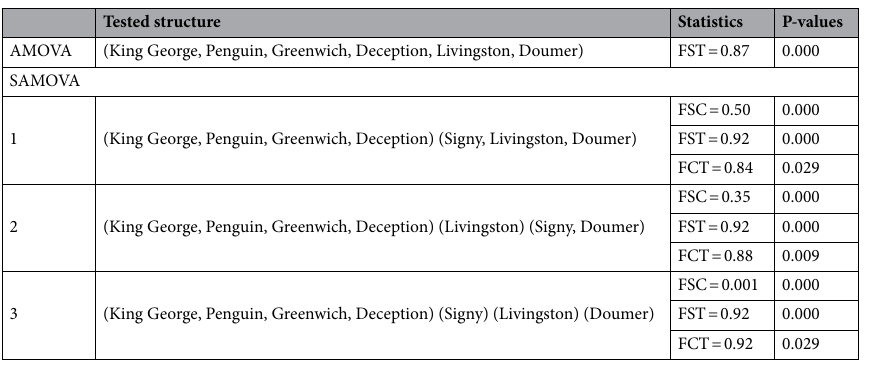
Table 2. Analysis of molecular variance in K. subquadrata . Output of the AMOVA and SAMOVA analysis. F SC : differentiation within islands among groups; F CT differentiation among groups and Fst estimates the differentiation among islands.